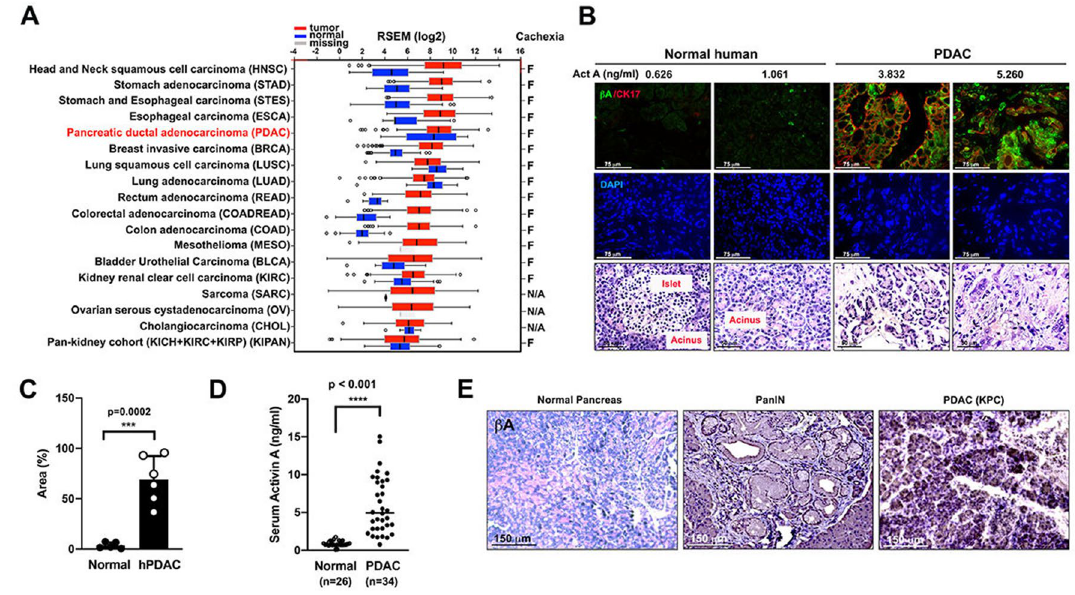
Figure 1. Activin A is highly expressed in tumor specimens from PDAC patients and enters systemic circulation. ( A ) Gene expression analysis of INHBA in 18 tumor types of The Cancer Genome Atlas (TCGA) compared with corresponding matched normal (TCGA) tissues using RNA-Seq by Expectation–Maximization (RSEM). Sources for the statistics of cancer cachexia prevalence can be found in Supplemental References. ( B ) Representative immunofluorescence images of activin A (βA, AF488) and keratin 17 (CK17, AF568) expression in non-cancerous pancreatic tissue and PDAC tumor specimens. Nuclei were stained with DAPI. Scale bar = 75 µm. Corresponding serum activin A levels are indicated in ng/ml. Representative H&E images are displayed on the third row. Scale bar = 50 µm. ( C ) Area percentage of green pixels indicating activin A expression in immunofluorescence images from non-cancerous pancreatic tissue ( n = 5 ) and PDAC tumor specimens ( n = 6 ). Each dot represents the average green pixel area percentage per image as measured by Image J. ( D ) Measurement of activin A levels in sera of non-cancer patients ( n = 25 ) and PDAC patients ( n = 34 ). ( E ) Representative immunohistochemical images of activin A expression in pancreas tissue from healthy control as well as PanIN lesions and tumor specimens from KPC